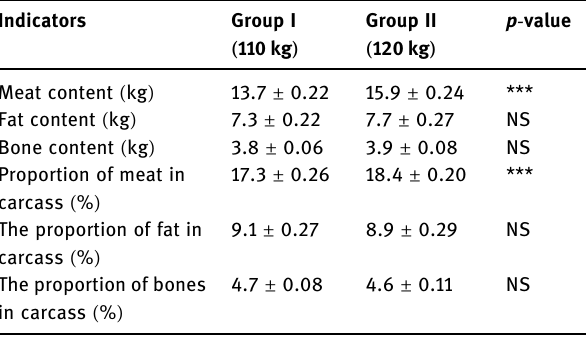
Table 4: Distribution of morphological composition in the pelvic - femoral third of the carcass of pigs of the experimental groups ( n = 60